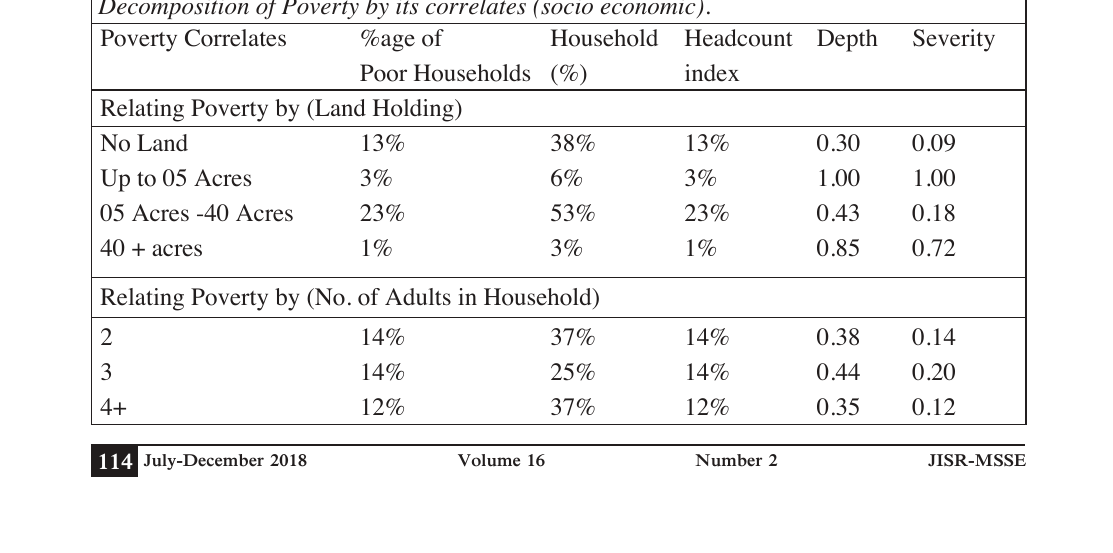
Decomposition of Poverty by its correlates (socio